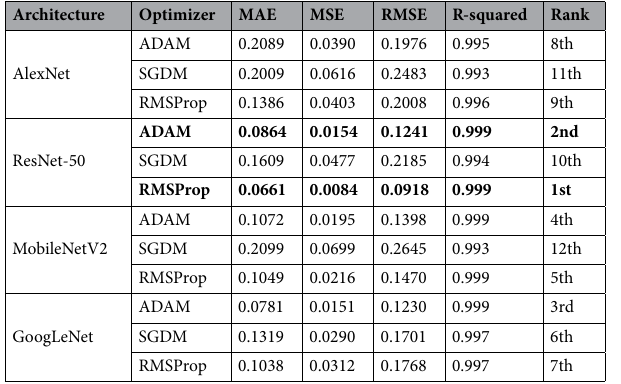
Table 5. CNN deep regression model performance on yeast cells for various architectures Significant values are in bold.